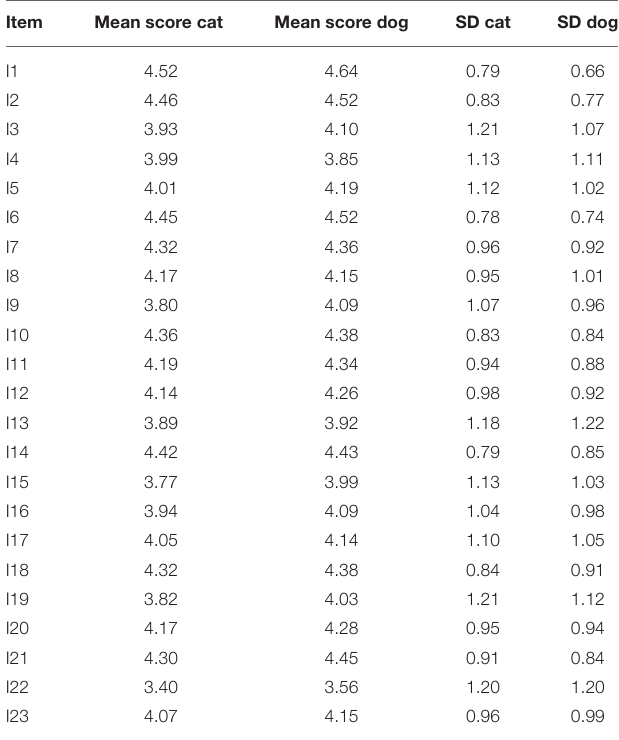
TABLE 5 | Item score means and standard deviations (SD).